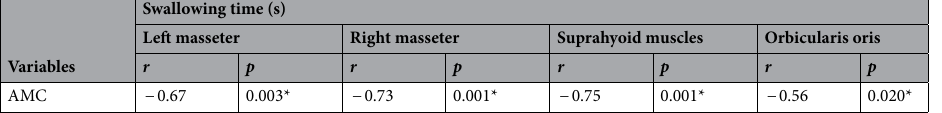
Table 4. Results for the correlation test between the contraction time of the muscles assessed in the sEMG during swallowing of pudding consistency and arm muscle circumference (AMC). p < 0.05—Spearman’s correlation coefficient. r correlation coefficient. *Statistically significant correlation ( p <